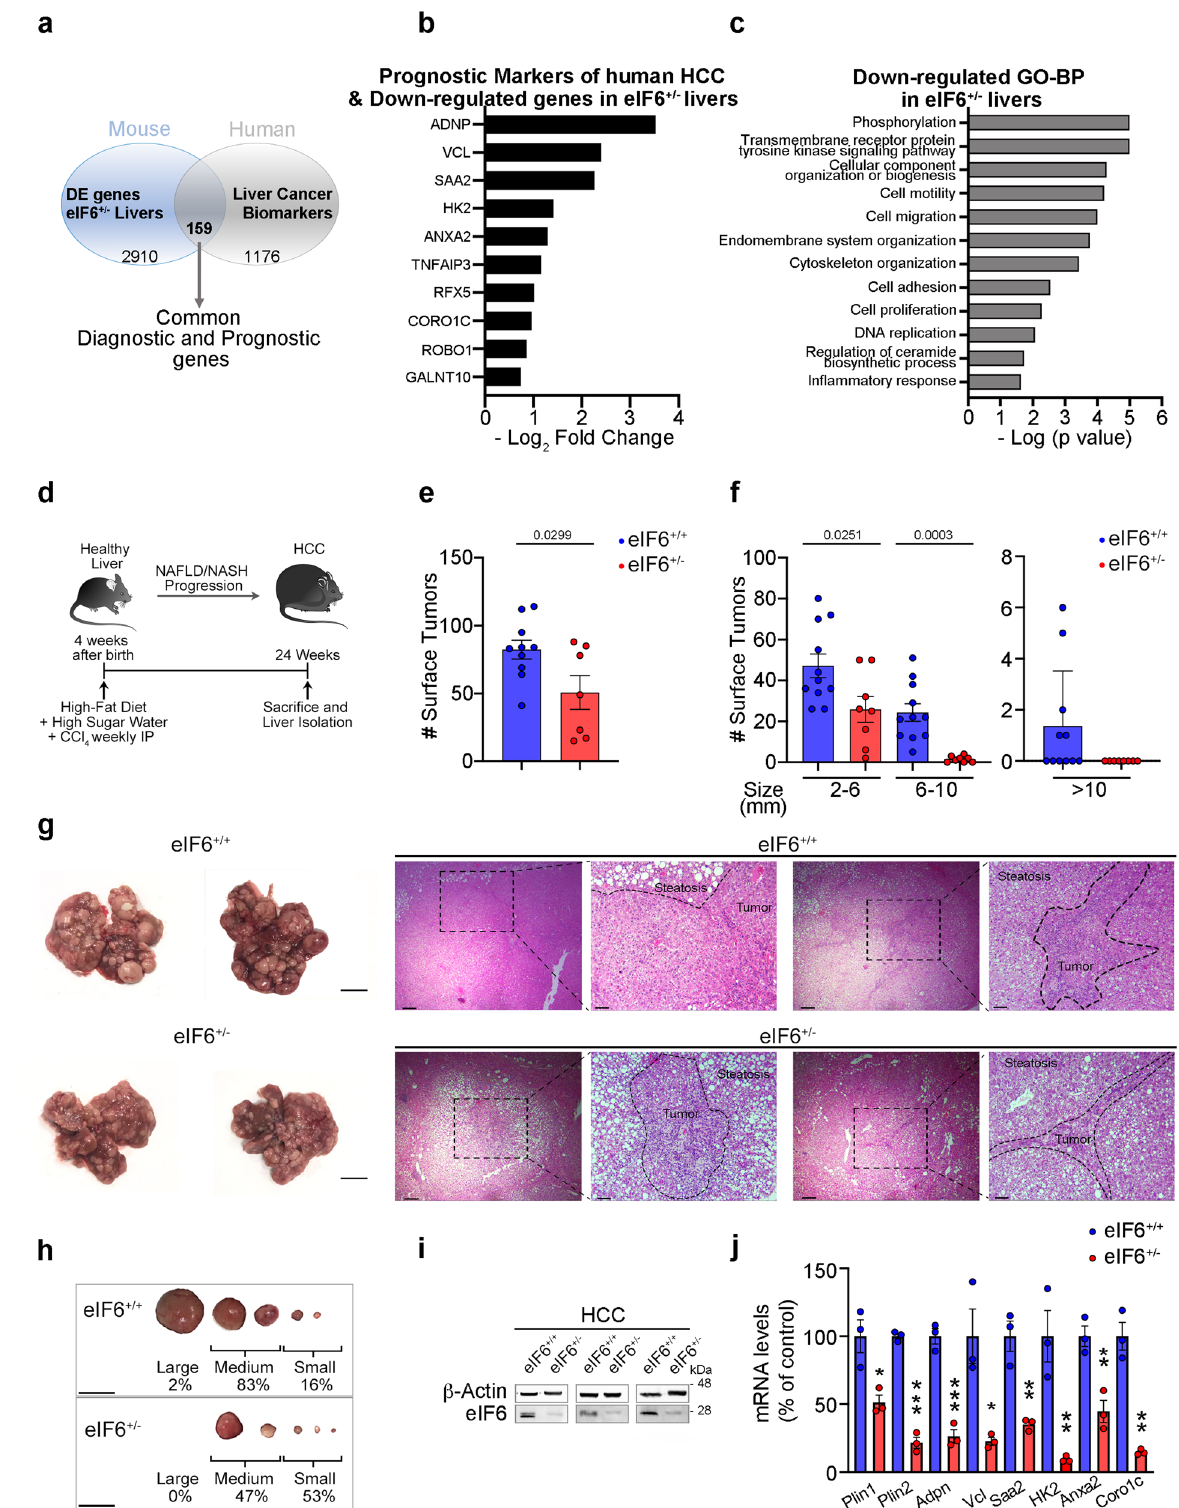
(Supplementary Fig. 5c). After the HFD regimen, intracellular ATP levels were higher in eIF6 + / − hepatocytes (Fig. 6f), but not lactate production (Fig. 6g), compared with wild-type counterparts. These results stress the fact that eIF6 long-term depletion, during HFD, leads to lower lipid accumulation in primary hepatocytes, preserving mitochondrial integrity and without increasing lactate production, i.e., an evident anti-Warburg 5